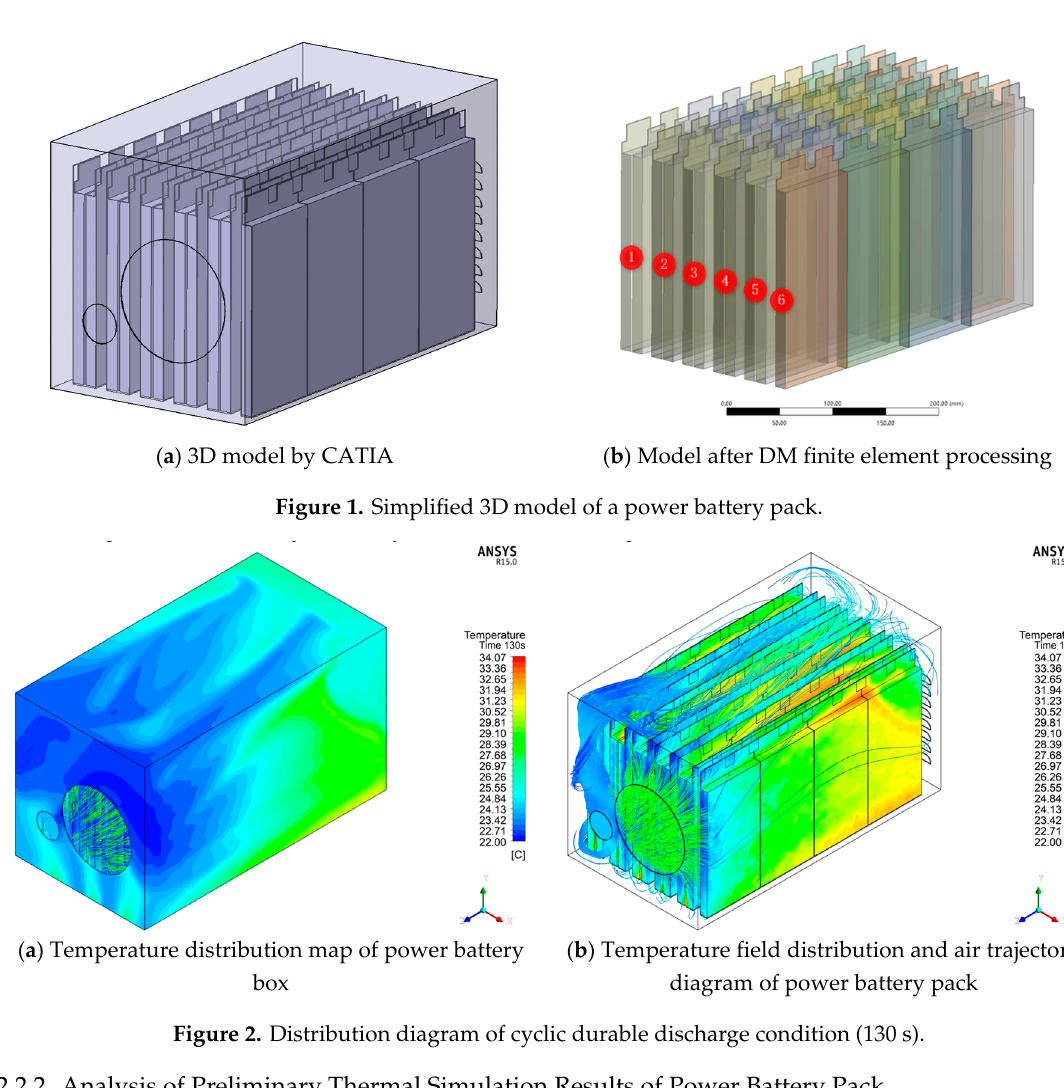
Figure 2. Distribution diagram of cyclic durable discharge condition (130 s).